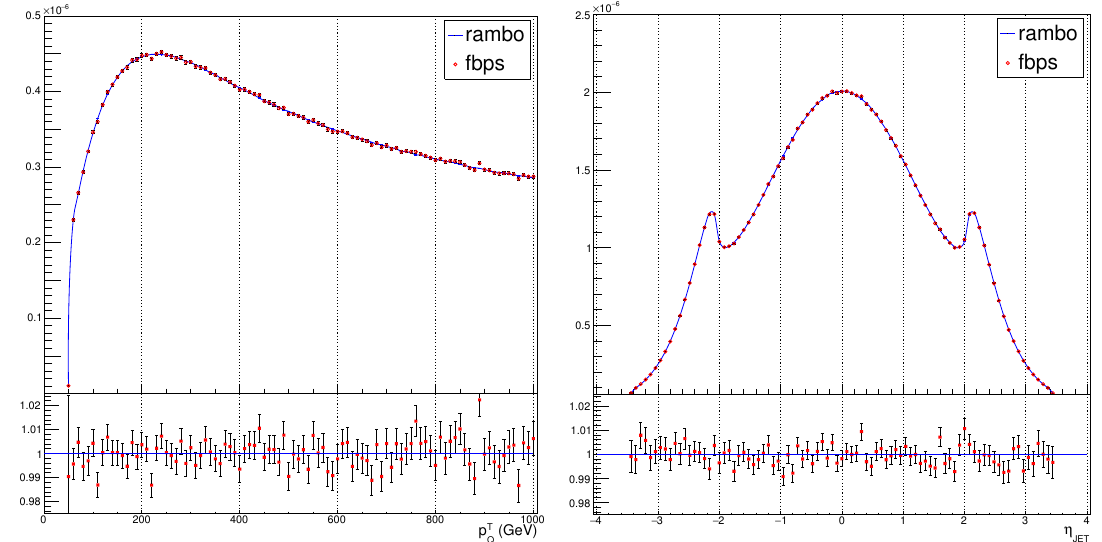
Figure 4 . A comparison between RAMBO and the FBPS generator of eq. (3.6). The left graph compares the vector boson p T , while the right graph compares the jet rapidity. For Rambo the V + 2 particle phase space was generated and a jet algorithm applied to obtain a V +1 jet exclusive (cid:12)nal state. For the FBPS generator the observables are the Born momenta, while the phase space weight is re-weighted by the bremsstrahlung